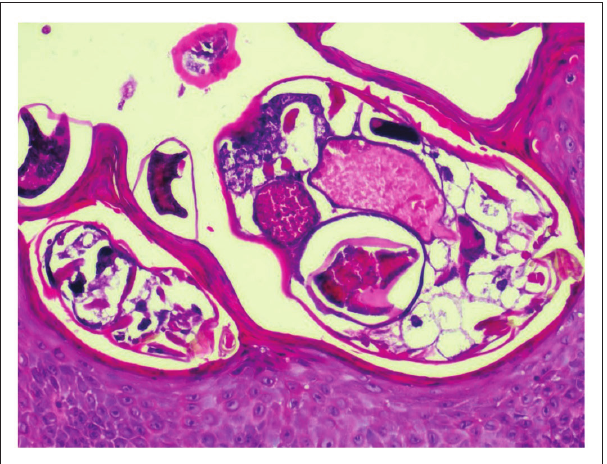
FIGURE 8: Higher magnification showing scabies mites (magnification x100).